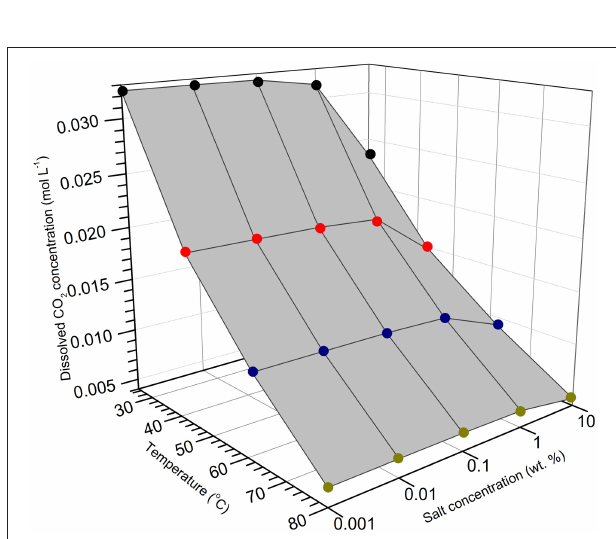
FIGURE 14 | OLI ® calculation of CO 2 solubility as a function of NaCl salt concentration and temperature.